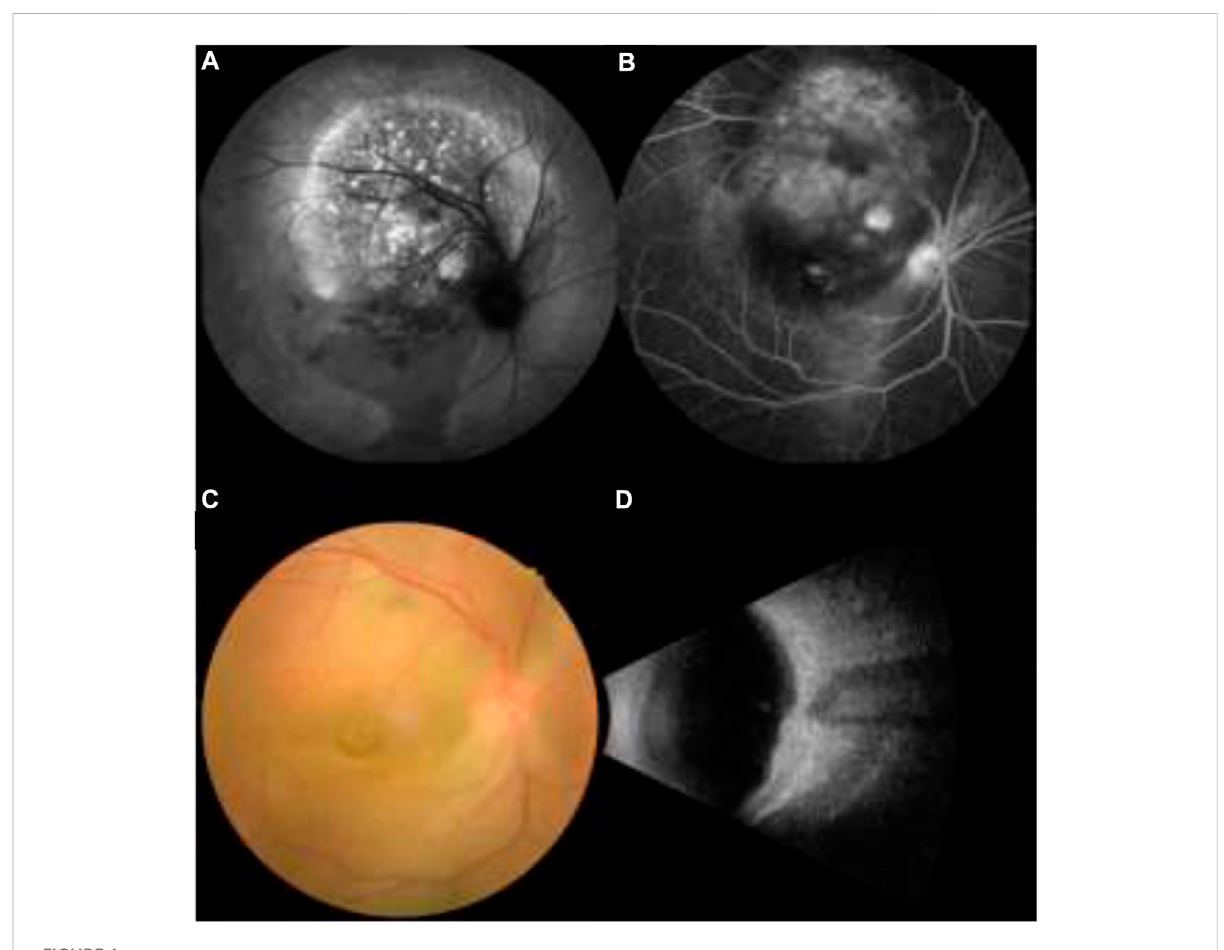
FIGURE 1 (A , B) Fundus fl uorescein angiography in patients with primary liver cancer, (C , D) Funduscopy in patients with primary liver